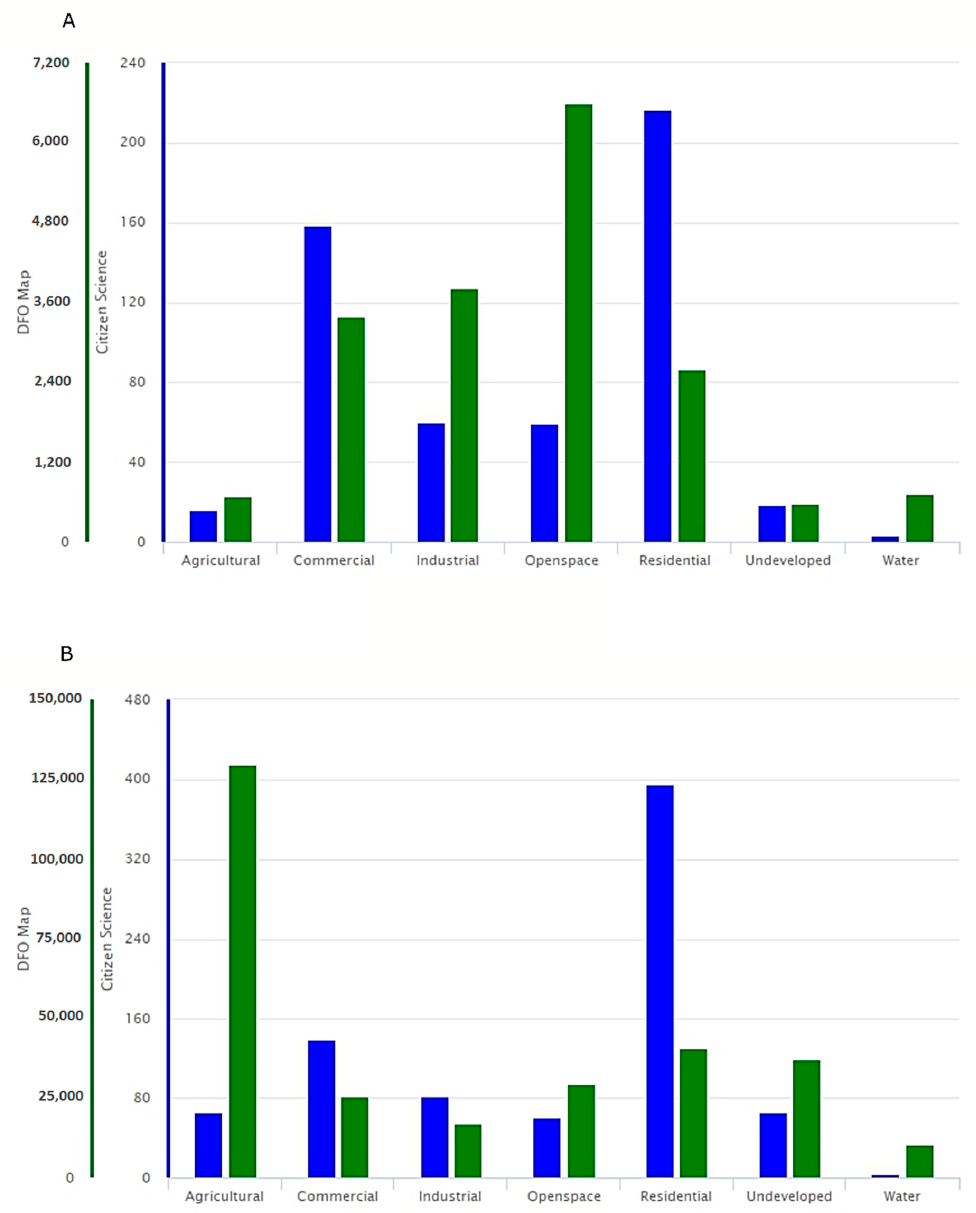
Figure 3. The flooded areas (in ha) under different land use types captured separately by Dartmouth Flooding Observation (DFO) maps and citizen science. ( A ) Land use compositions in flooded areas inside the city center; ( B ) land use compositions in flooded areas outside the city center.